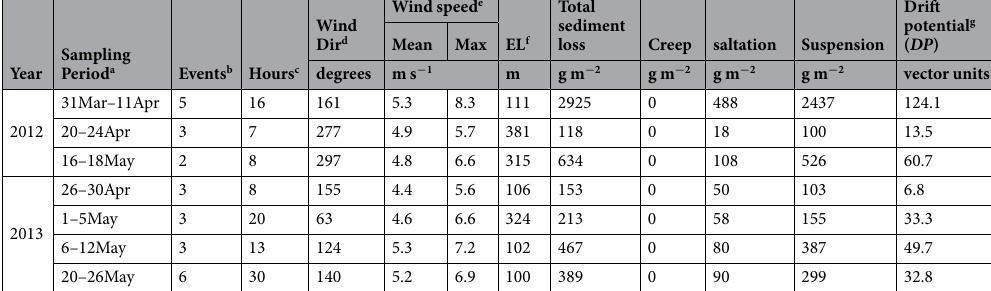
Table 1. High wind event characteristics and total measured sediment loss partitioned by creep plus saltation, and suspension in the desert-oasis ecotone during 2012 and 2013. a Dates over which eroded sediment was collected. b Number of high wind events observed during the sampling period. A high wind event was defined by wind speeds that exceeded 4 m s − 1 at a height of 1 m. c Number of hours during the sampling period for